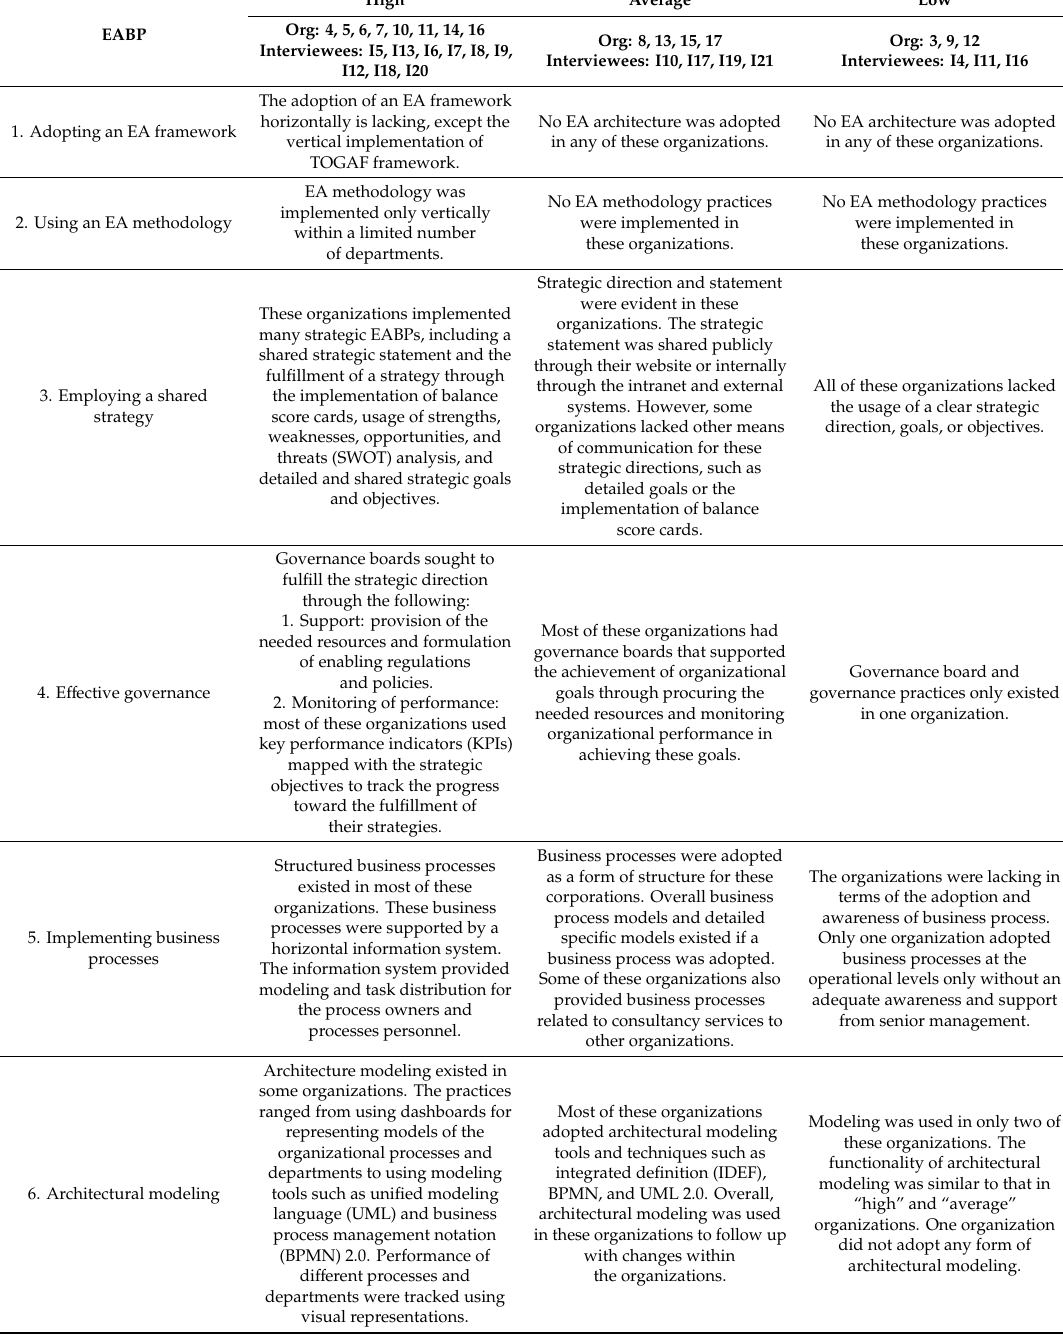
Table 6. Summary of the used EABPs for the organizations evaluated as “high,” “average,” and